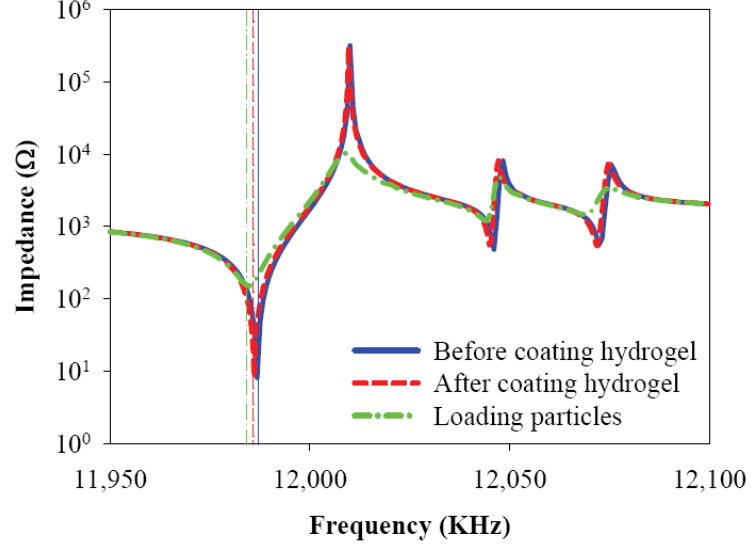
Figure 4. A QCM frequency-impedance test with an HP4294 at three stages: before coating hydro-gel, after coating hydro-gel, and after loading particles. The sharp nodes in the impedance curves represent the resonant frequency points of the QCM sensor. The shift of the first resonant frequency is measured when particles are applied on the surface of the QCM sensor